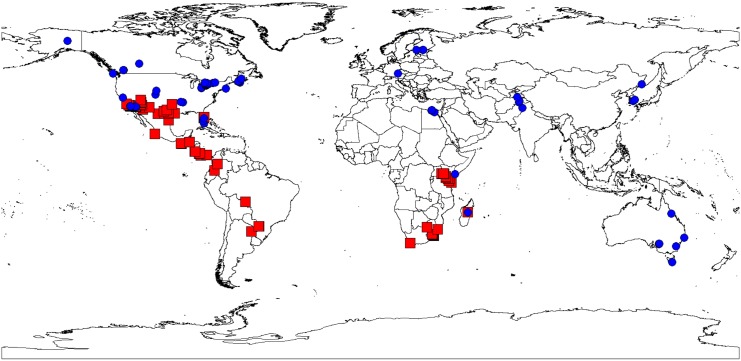
Worldwide distribution of Apis mellifera mitotypes based on a single nucleotide polymorphism at position 2382 [32] of the Apis mellifera mitochondrial genome.401 high-quality Apis mellifera sequences were downloaded from the Barcode of Life Database (Barcode Index Number BOLD:AAA2326, S5 Table). Red: locations of individuals with a cytosine at position 2382. Blue: locations of individuals with a thymine at that position (see text).